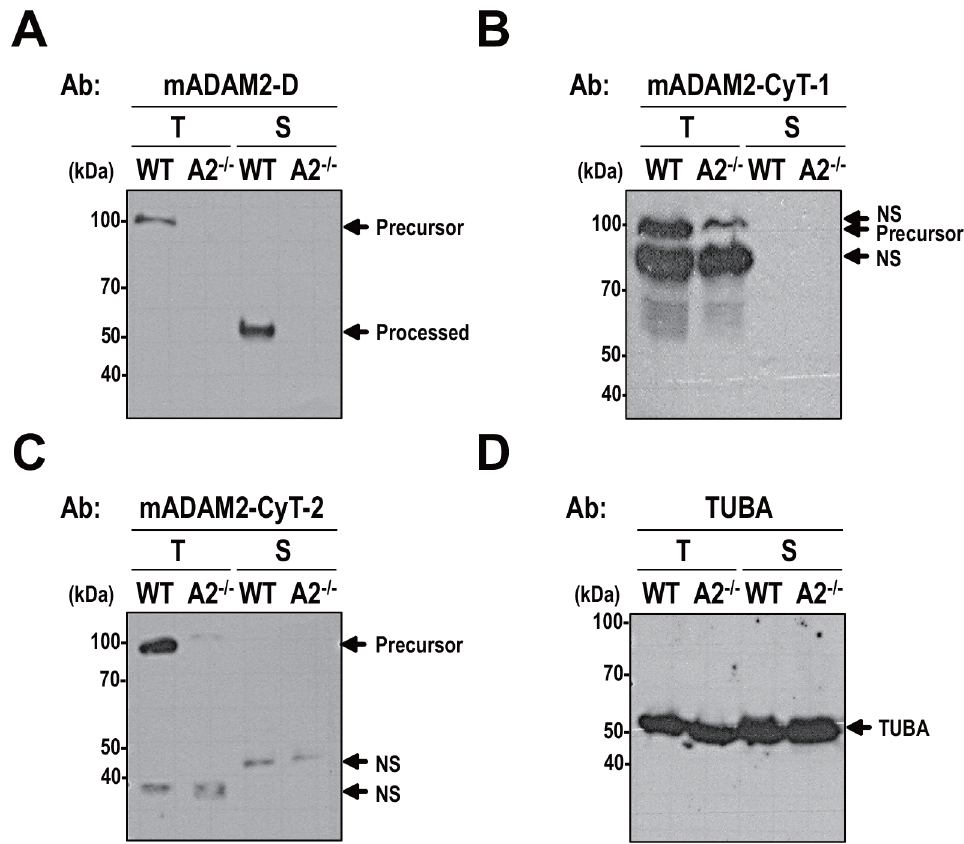
Fig 1. Immunoreactivity of mouse ADAM2 antibodies. Lysates from testicular cells and sperm from wild- type and Adam2 -/- mice were boiled in 3% SDS and 5% β -mercaptoethanol and subjected to Western blot analyses. A . Western blotting with the anti-mADAM2-D antibody. This antibody was raised against the ADAM2 disintegrin domain, and recognized the precursor (100-kDa) and processed (45-kDa) forms of ADAM2 in mouse testis and sperm, respectively. B and C . Blots performed using two different antibodies, which were raised against the cytoplasmic tail domain and designated B . anti-mADAM2-CyT-1 and C . anti-mADAM2-CyT- 2. D . An antibody against a-tubulin (TUBA) was included as a control. Experiments were repeated three times. Reduced protein samples were subjected to SDS-PAGE using 10% resolving gels. Abbreviations: T, testicular cells; S, sperm; WT, wild-type; A2 -/- , Adam2 -/- ; NS, non-specific. Molecular masses are presented on the left.